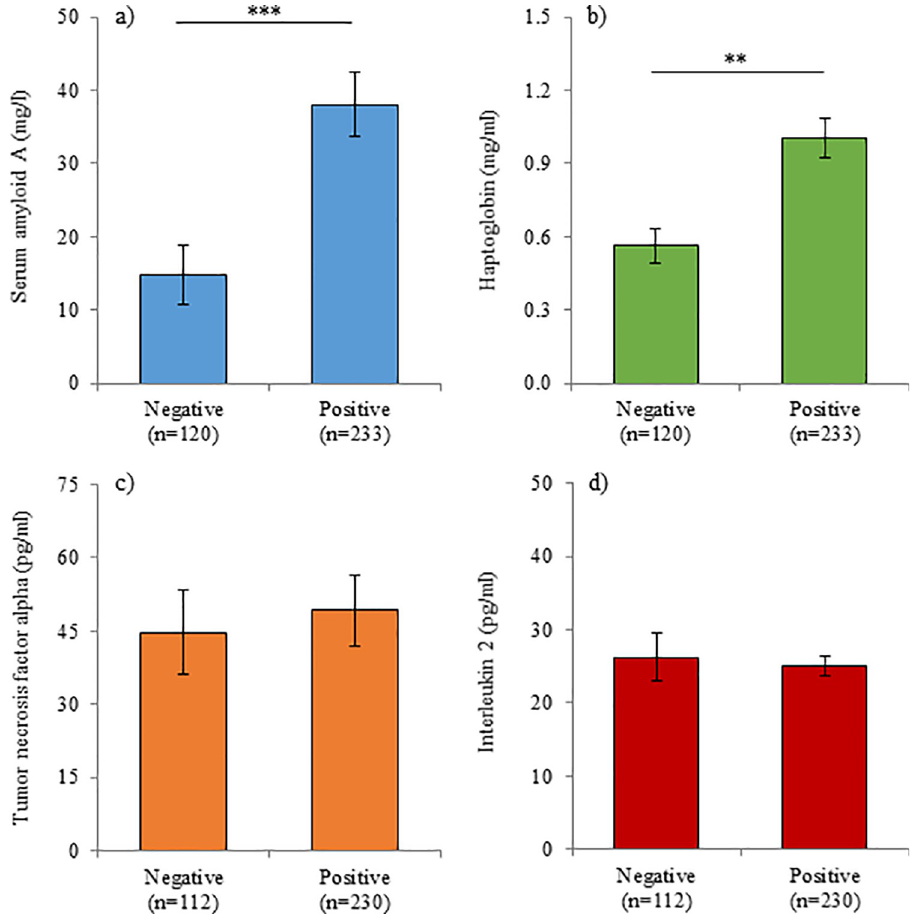
Fig 1. Acute phase protein and cytokine concentrations with positive or negative viremia. Serum concentrations of serum amyloid A (a), haptoglobin (b), tumor necrosis factor alpha (c) and interleukin 2 (d) on days when whole blood was positive or negative for EEHV viremia by PCR. Bars represent the mean ± sem of the prediction from the GLMM; asterisks denote significant differences between categories ( �� P < 0.01; ��� P < 0.001). mg/ml. In the case presented in Fig 5B, APP concentrations were relatively low during EEHV5 viremia, but elevated SAA and HP concentrations around Day 38 coincided with increased EEHV1 viremia concurrent with EEHV5. Interleukin-2 was below assay detection for all five cases represented in Figs 4 and 5, and TNF- α was only detected in two cases. An 11-year old female with EEHV1 exhibited TNF- α concentrations averaging 32.8 pg/ml that remained fairly consistent throughout the viremia (Fig 4B). Another 11-year-old female with EEHV5 exhibited a steady increase in TNF- α from Day 5 to 14 (Fig 5C); concentrations then remained elevated for the remainder of the sample collection period. The case of EEHV3B in a male African ele- phant was described by Bronson et al. [30], and here daily samples were additionally analyzed for APP and cytokine concentrations (Fig 6) to provide a longitudinal profile of each bio- marker. TNF- α concentrations increased on Day 3 of detected viremia, peaked at 85.1 pg/ml on Day 4 and then gradually declined in parallel with decreasing viremia to below assay detec- tion on Day 30 (Fig 6C). IL-2 was also elevated on Day 3, peaked on Day 4 (134.0 pg/ml) and began to decrease by Day 9, after which concentrations remained relatively stable until the end of the collection period (Fig 6D).